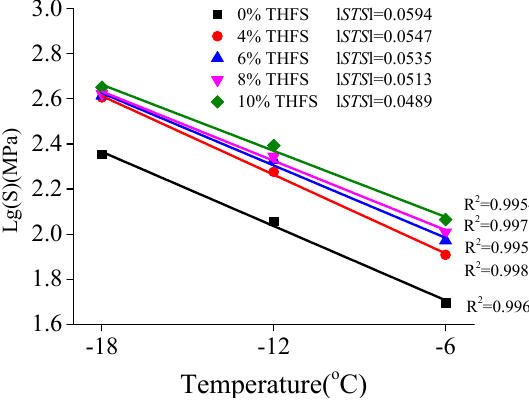
Figure 7. Relationships between lg(S) of Asphalt Binders and Temperatures.